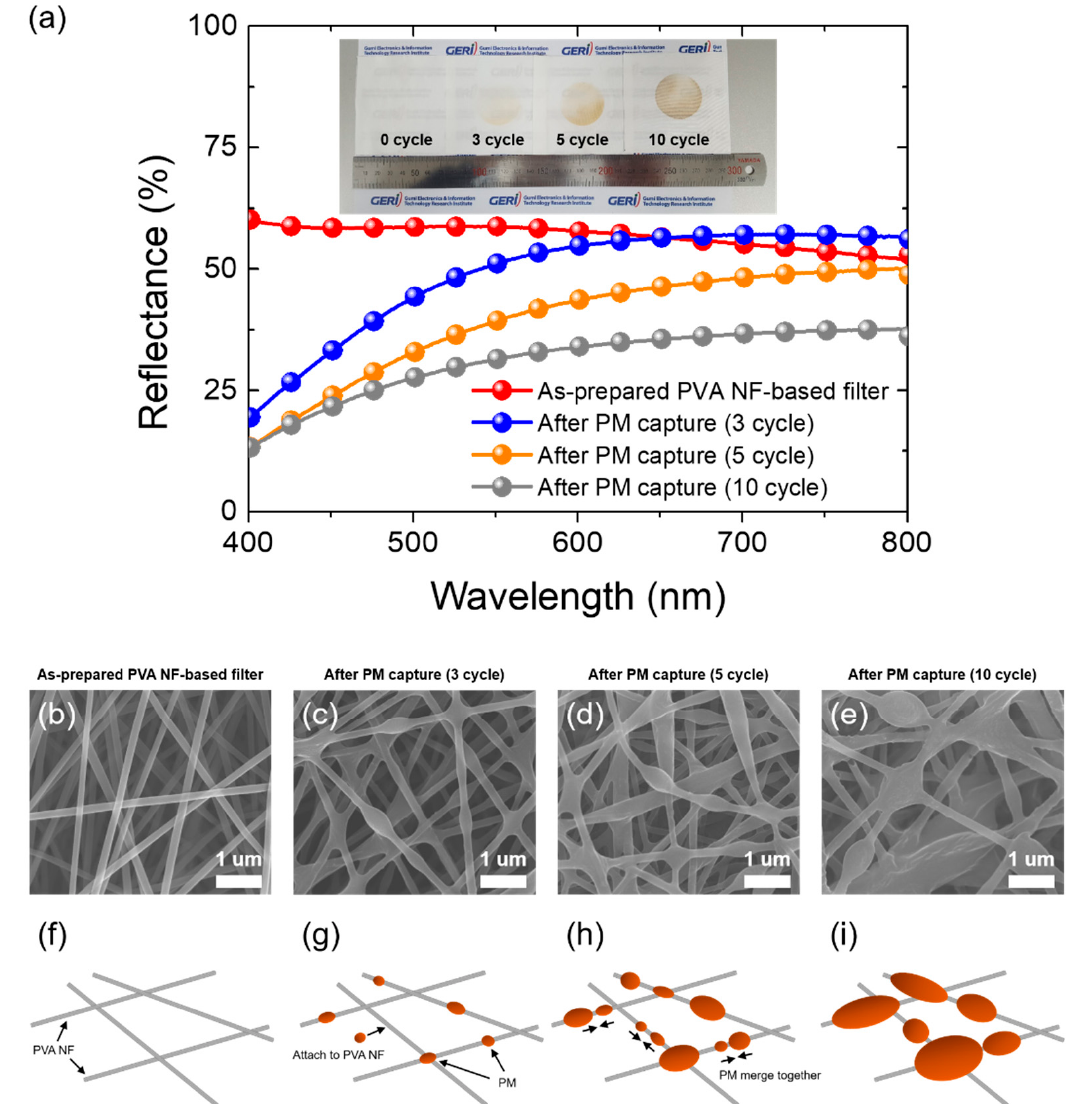
Figure 3. Optical and structural changes in PVA NF-based filter (electrospinning time: 300 s) during repeated chamber tests. ( a ) Changes in the reflectance spectrum of PVA NF-based filter according to repeated chamber tests; ( b – e ) surface RE-SEM images of PVA NF-based filters according to the amount of PM collected; ( f – i ) schematics showing the mechanism of PM capture by PVA NF-based filter at different time sequences.